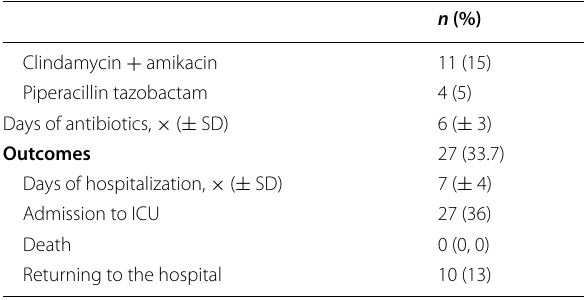
Table 1 Clinical and laboratory